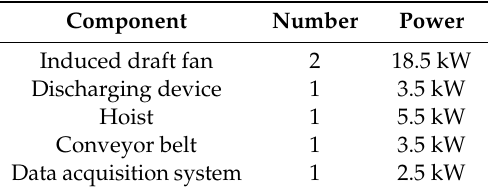
Figure 1. The scene graph of the industrial drying system. Table 1. Details of the instruments.